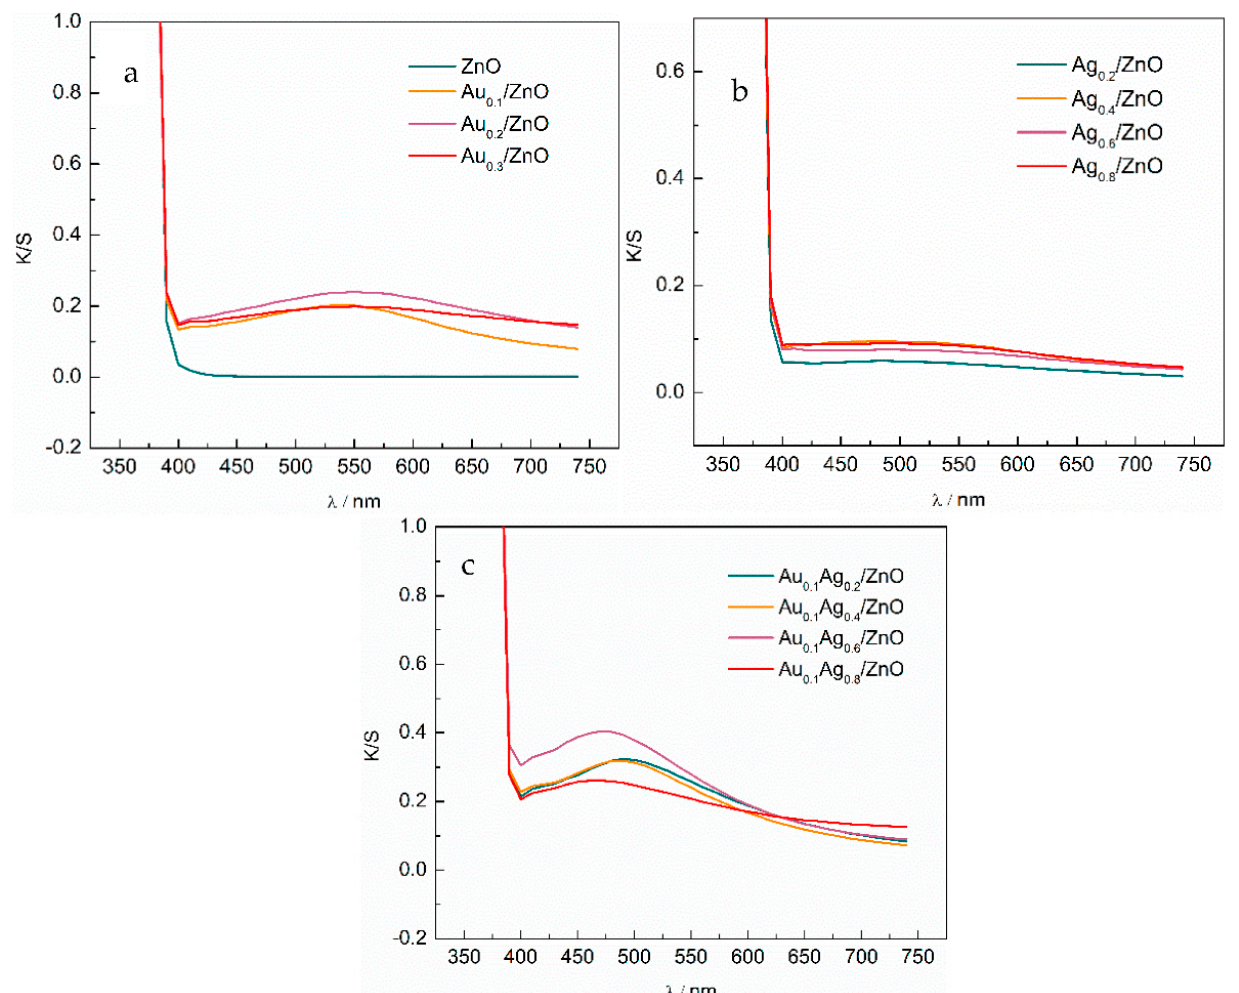
Figure 2. Diffuse reflectance UV-vis spectra of respective catalysts ( a ): ZnO and Au/ZnO; ( b ): Ag/ZnO; ( c ): Au-Ag/ZnO).